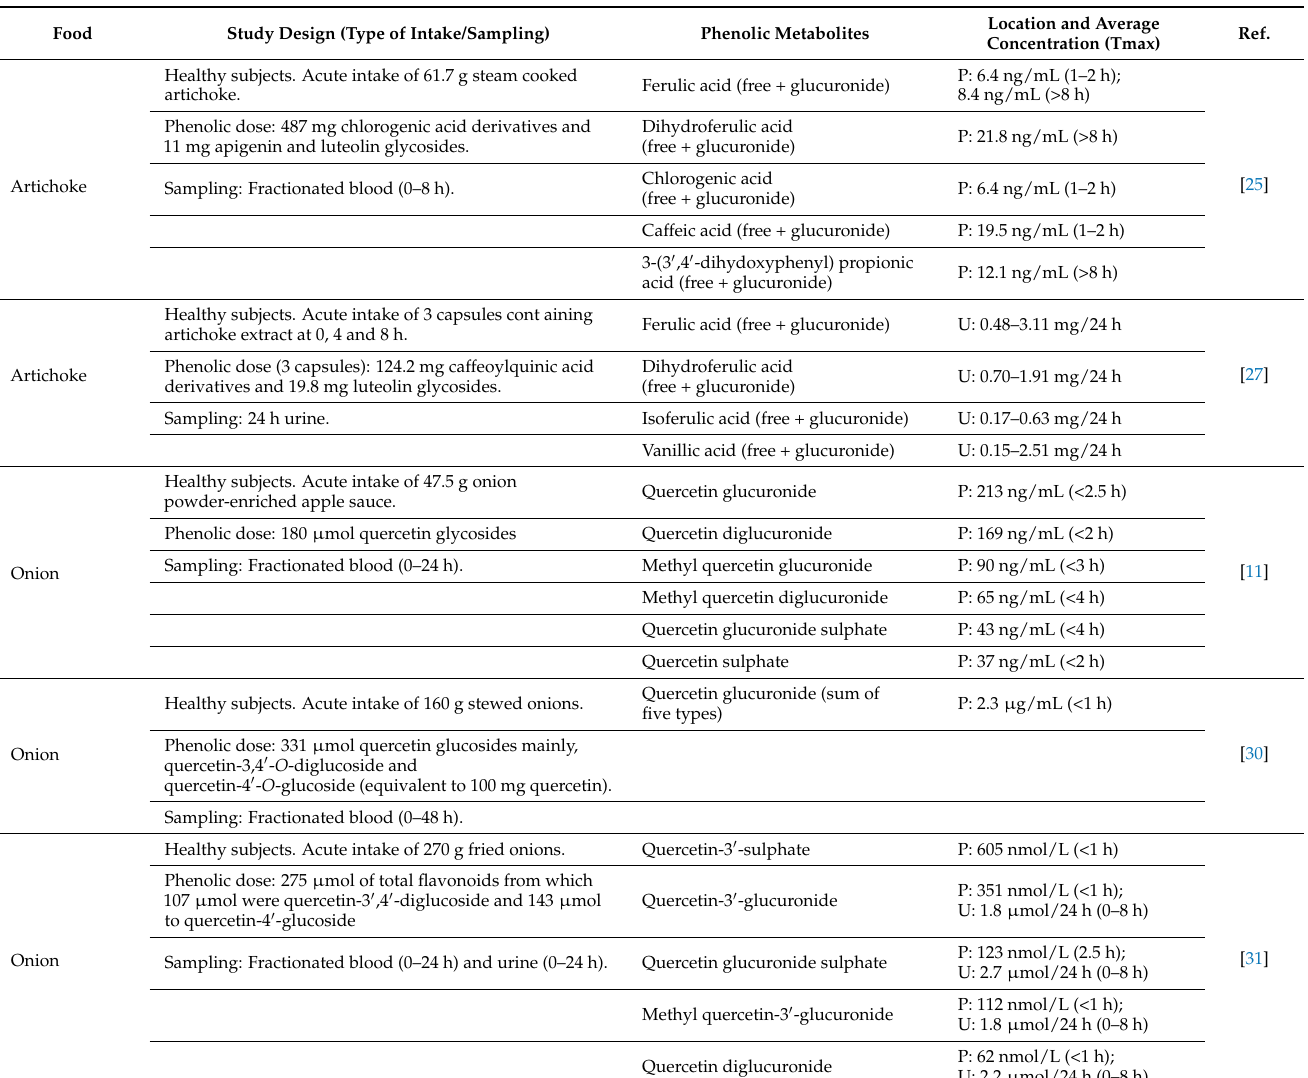
Table 1. Phenolic metabolites (phase I, phase II) proposed as intake biomarkers of vegetables commonly consumed in the Mediterranean